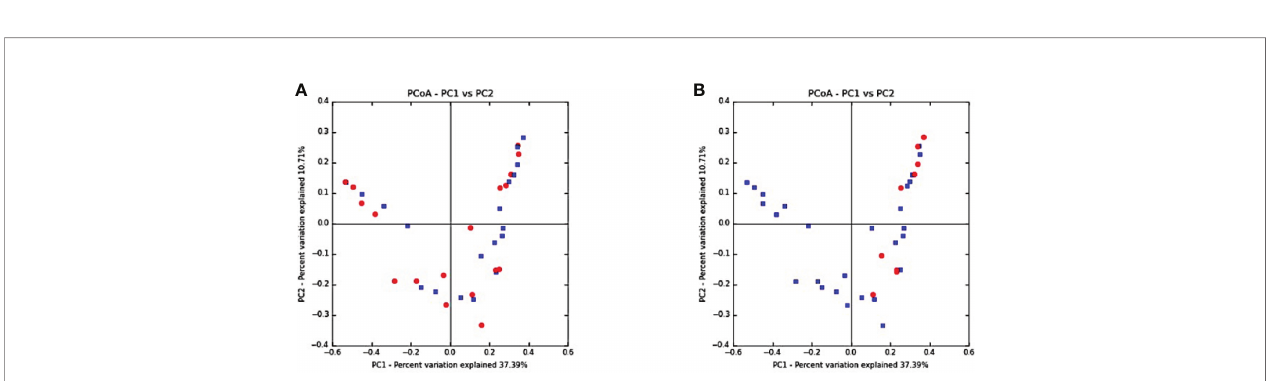
FIGURE 2 | Two measures of alpha diversity in whole saliva samples from groups with healthy peri-implant site (blue) and groups with peri-implantitis (red). (A) Shannon index, (B) Simpson Diversity Index.